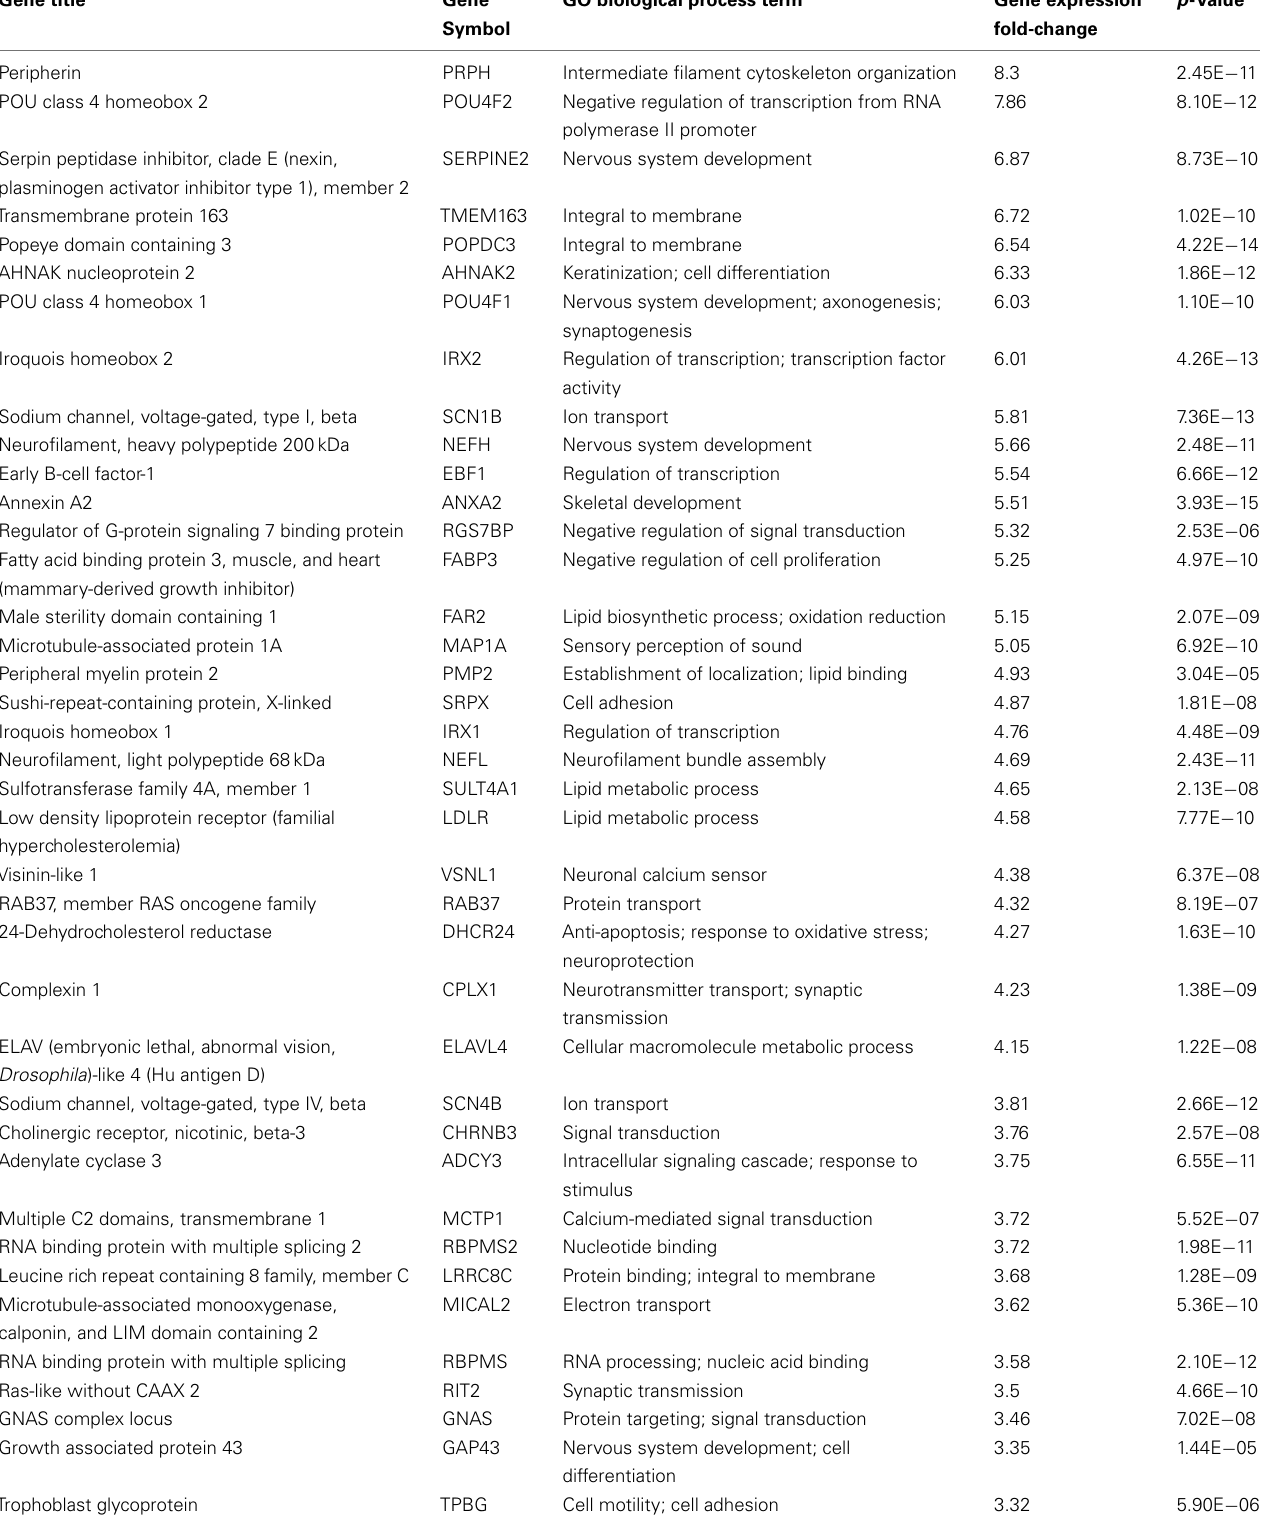
Table 3 | Genes highly expressed (up-regulated) in macula compared to peripheral